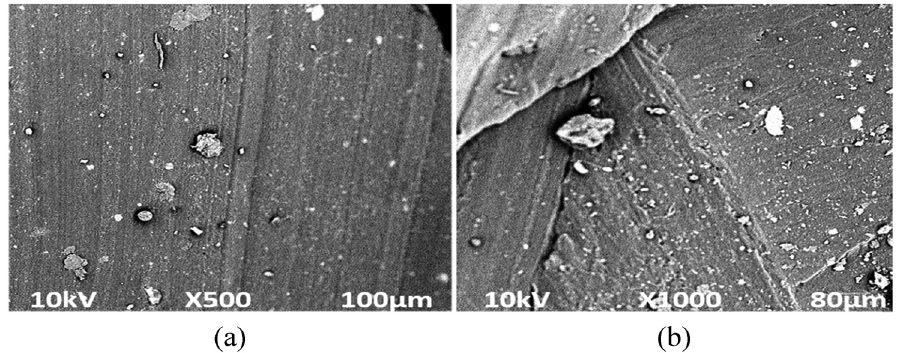
Figure 32: SEM tensile - fractured micrographs of Neat recycled EVA polymer without leather fi bers at a magni fi cation of ( a ) 500 × ; ( b ) 1,000 × .